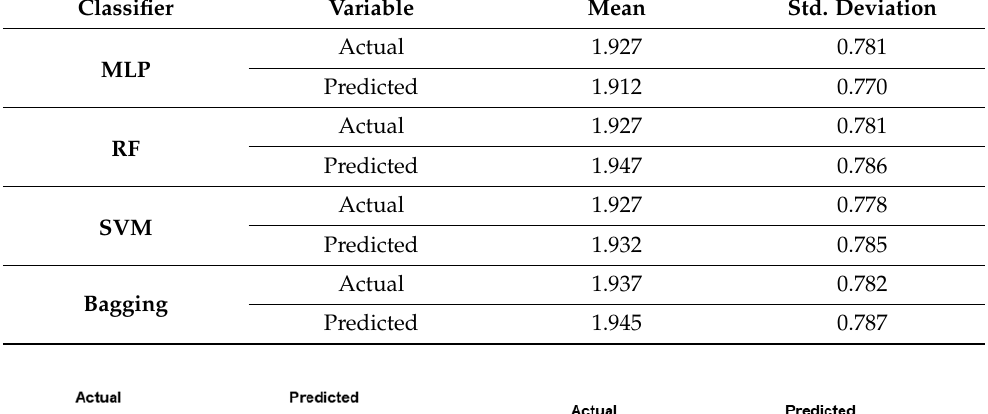
Table 6. Correlation between the actual and the predicted values for the classifiers.